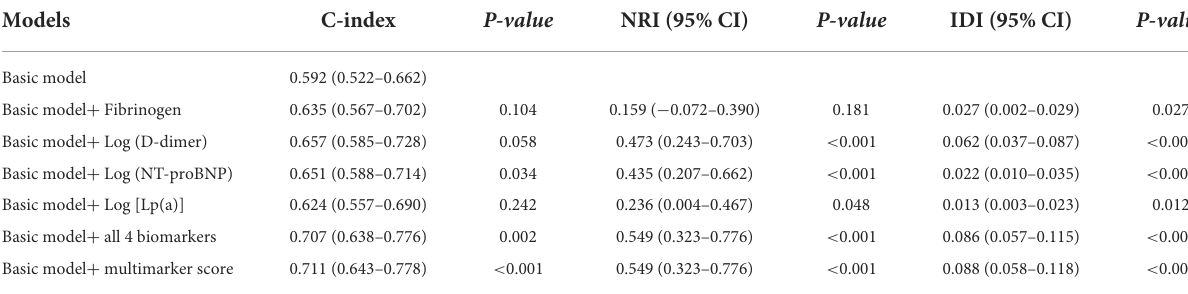
TABLE 6 Additional predictive value provided by candidate biomarker beyond that of the basic model.